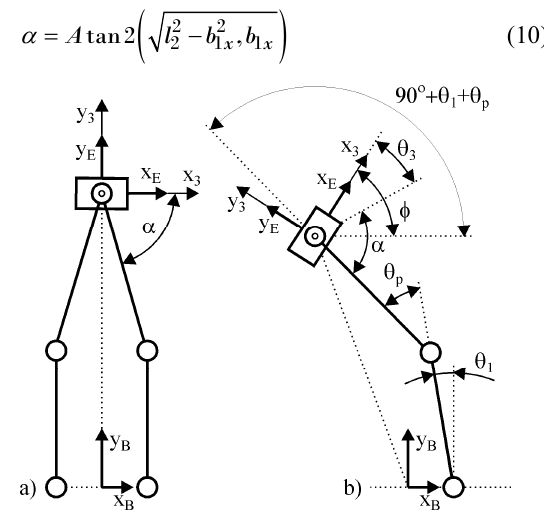
Figure 4. Determination of the orientation